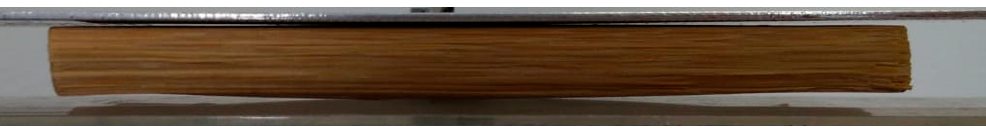
Figure 18. Fiber volume fraction of ( a ) normal bamboo, and ( b ) reformed bamboo (data from [31]).